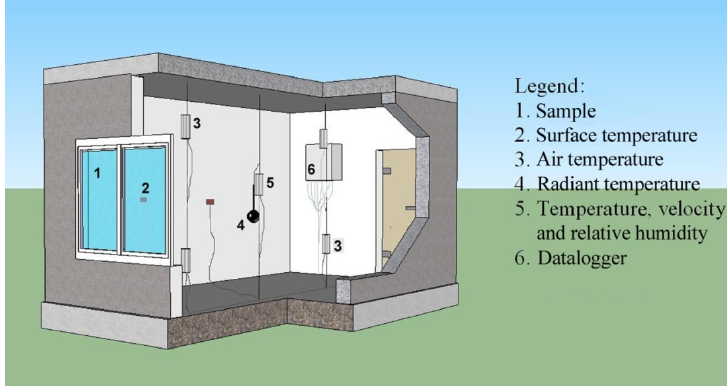
Figure 1. Section of the test cell and position of the internal sensors.